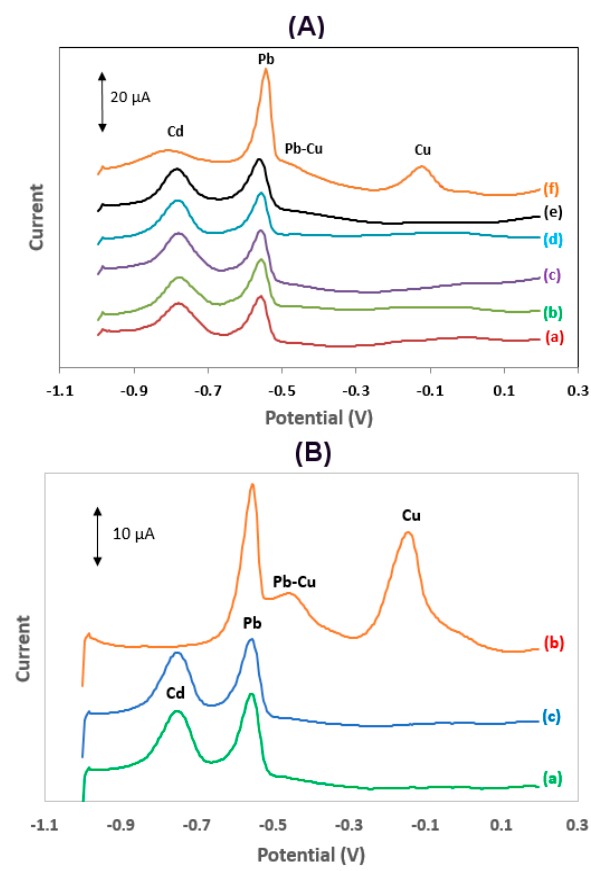
Figure 6. ( A ) Voltammograms for the determination of 25 µ g L − 1 of Pb(II) and Cd(II) ( a ) before, and after the successive addition of 50 µ g L − 1 of: ( b ) Sn(II), ( c ) Zn(II), ( d ) Tl(I) + In(III), ( e ) Hg(II) + As(III), and ( f ) Cu(II); ( B ) ( a ) voltammograms for the determination of 25 µ g L − 1 Pb(II) and Cd(II), ( b ) after the addition of 150 µ g L − 1 Cu(II), ( c ) as (b) after the addition of 1.0 × 10 − 5 mol L − 1 K 4 [Fe(CN) 6 ] (voltammograms are offset for clarity). Conditions as in Figure 4.